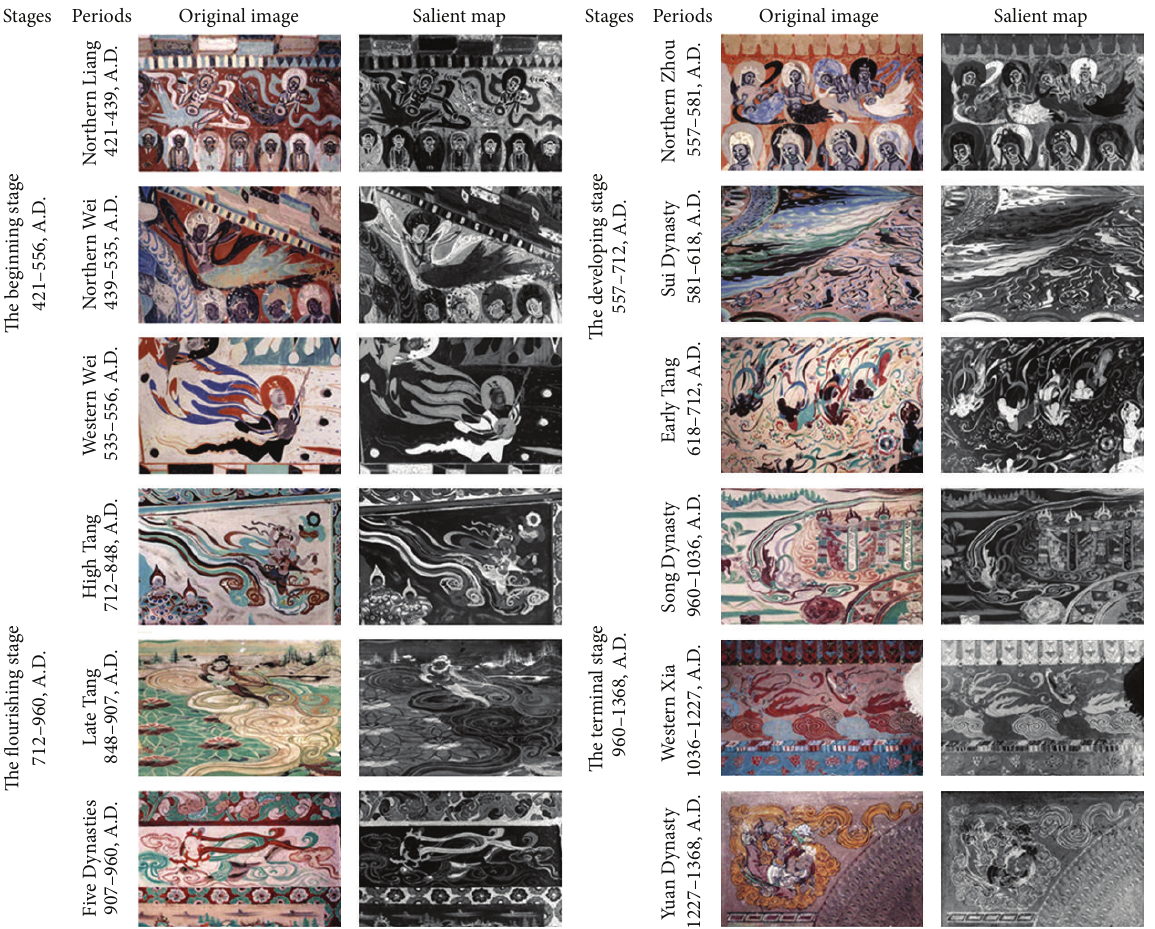
Figure 2: Visual saliency detection results of Flying Apsaras in the Dunhuang Grotto Murals within four historical periods: the beginning stage, the developing stage, the flourishing stage, and the terminal